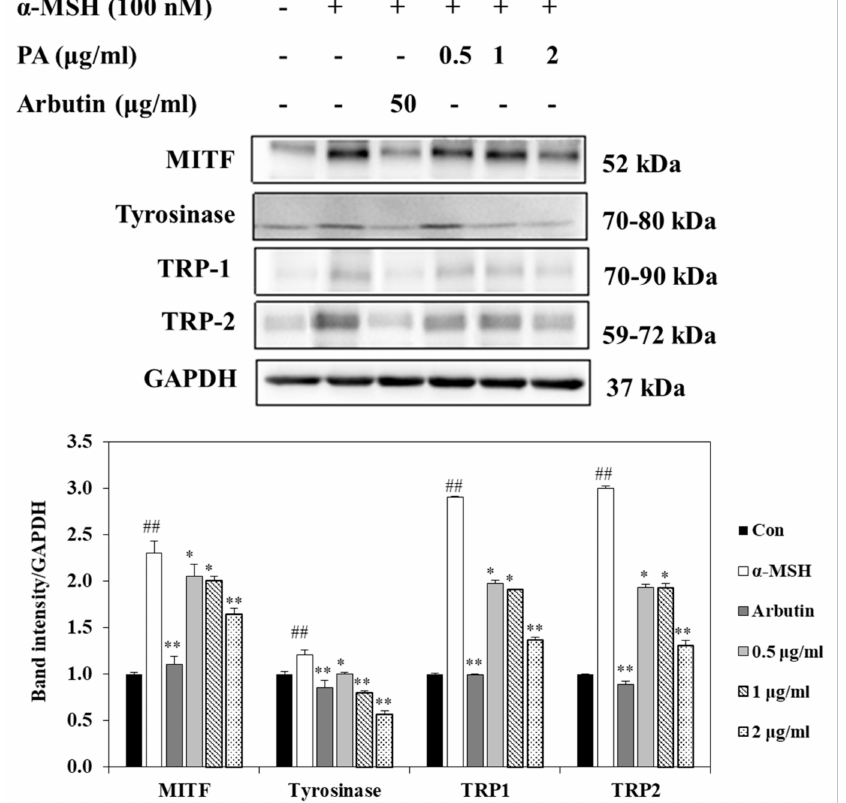
Figure 3. Inhibitory effects of PA on the expression levels of proteins related to melanogenesis in α -MSH-stimulated B16F10 cells. Cells were exposed to 100 nM α -MSH in the presence of PA at the indicated concentrations or 50 µ g/mL arbutin. The expression levels of MITF, tyrosinase, TRP-1, and TRP-2 were measured using Western blot analysis and quantified using Image J. Values are expressed as means ± SDs of triplicate experiments ( n = 3). Note: ## p < 0.01 compared to the untreated control group; * p < 0.05 and ** p < 0.01 compared to the α -MSH